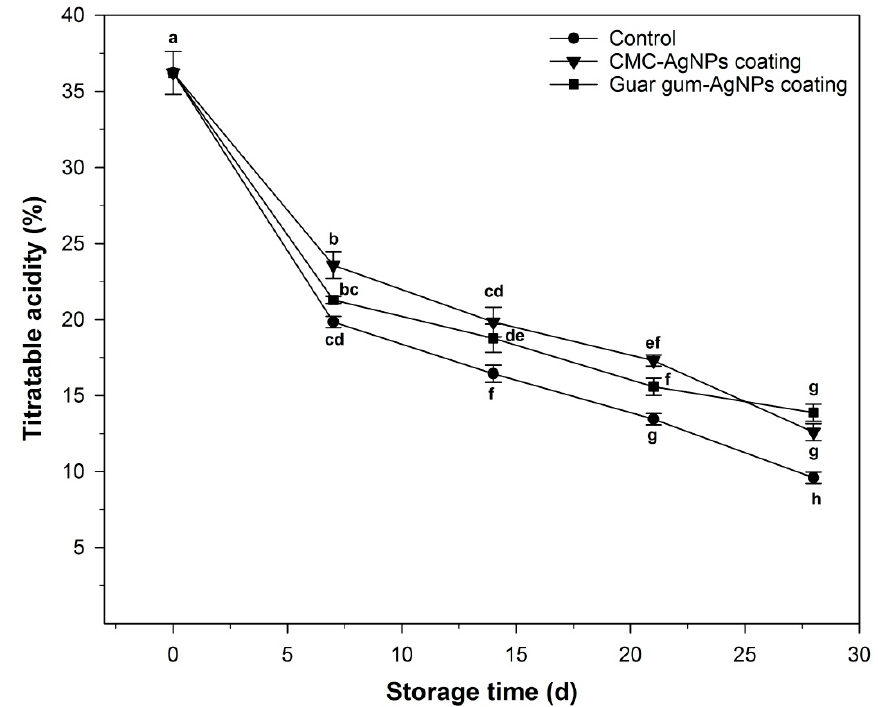
Figure 9. Effect of CMC-AgNP and guar gum-AgNP coatings on titratable acidity (TA) of “Seddik” mango fruits stored at 13 °C for 4 weeks. Vertical bars represent the SE of means. Means with the same letter are not significantly different according to Duncan’s multiple range test ( α ≤ 0.05).